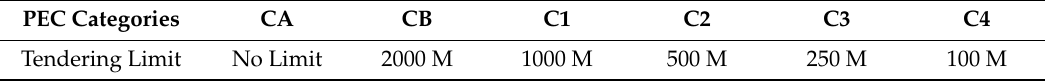
Table 1. PEC (Pakistan Engineering Council) Category and Tendering Limit of Companies. PEC Categories